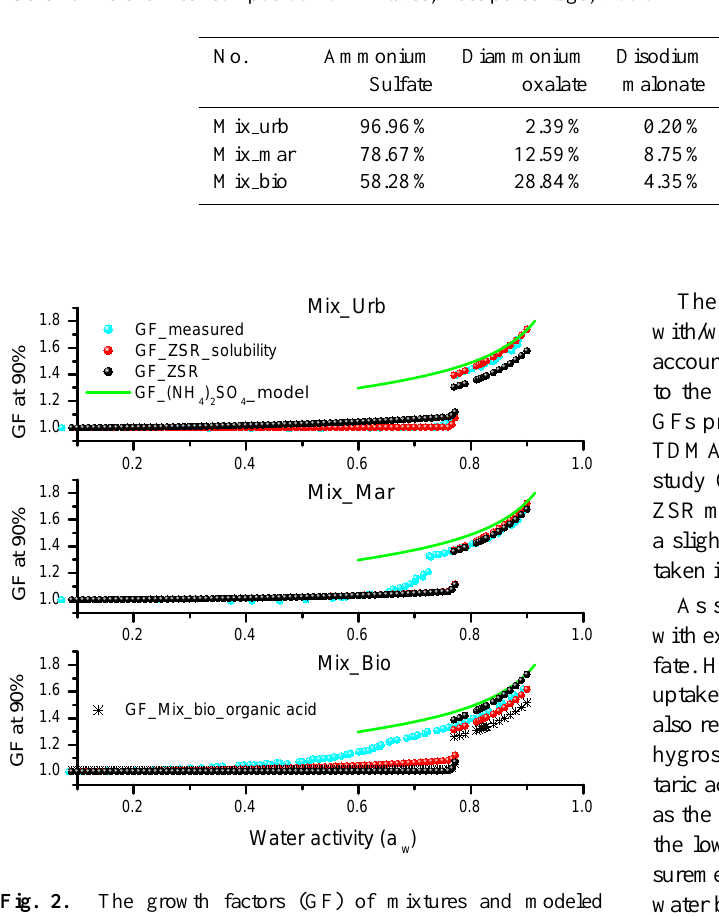
Fig. 2. The growth factors (GF) of mixtures and modeled (NH 4 ) 2 SO 4 versus water activity ( a w )